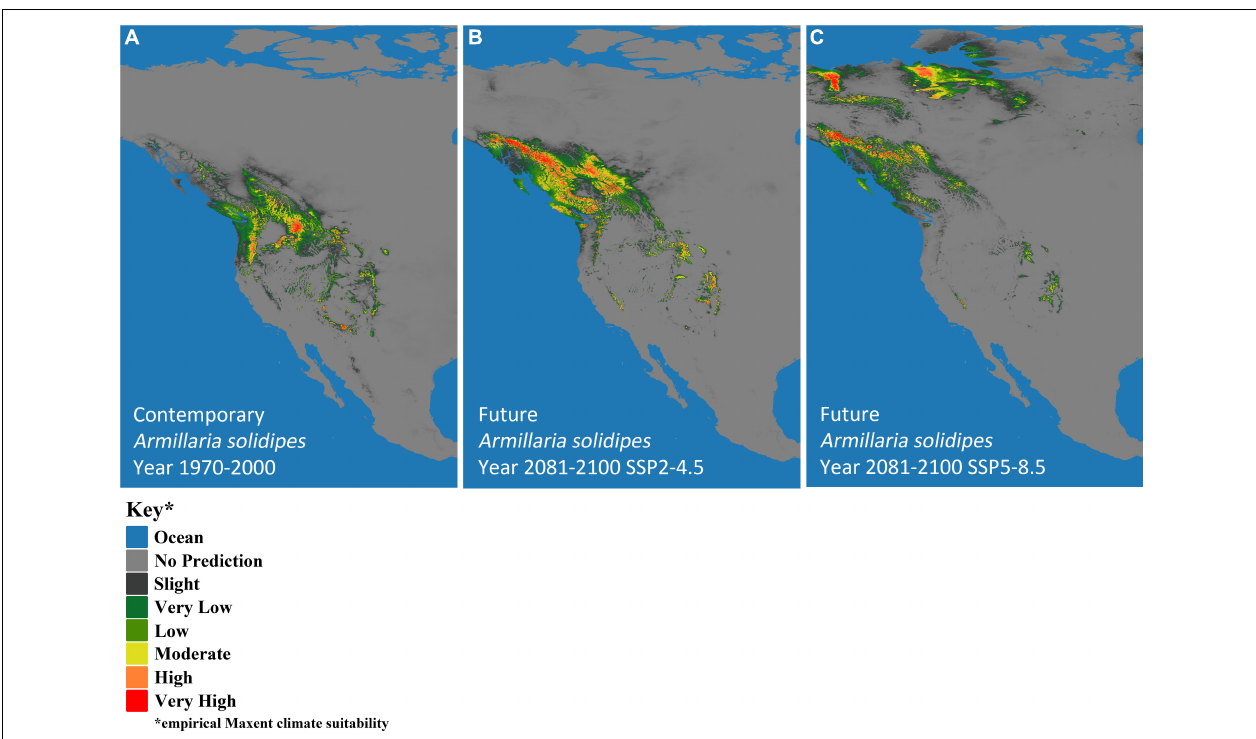
FIGURE 3 | MaxEnt-based, bioclimatic models for Armillaria solidipes in western North America. (A) Contemporary years (1970–2000) and two future models show two Shared Socioeconomic Pathway (SSP) scenarios (SSP2-4.5 and SSP5-8.5), (B) SSP2-4.5 and (C) SSP5-8.5. Darkest gray represents predicted empirical MaxEnt climate suitability, with dark green, light green, yellow, orange, and red indicating increased probability of climatic suitability, respectively.